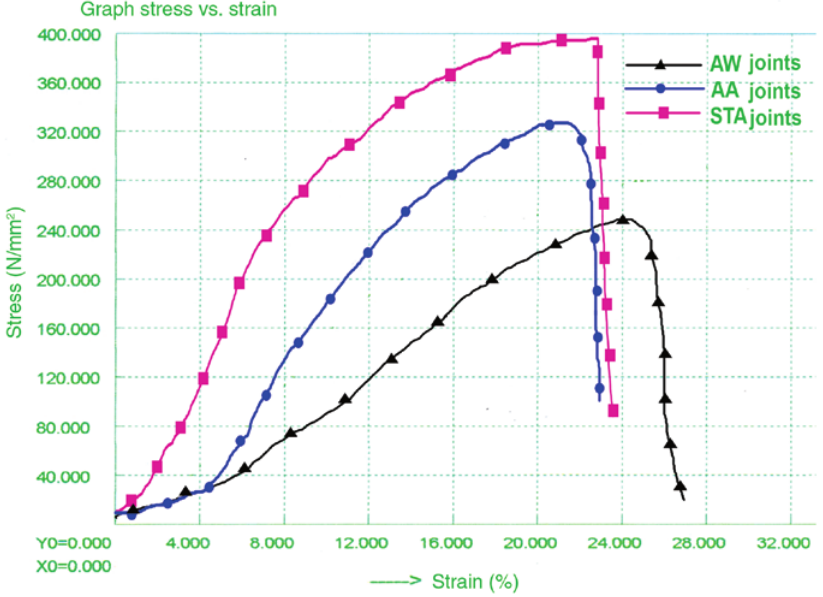
Figure 1: Stress-strain curves.